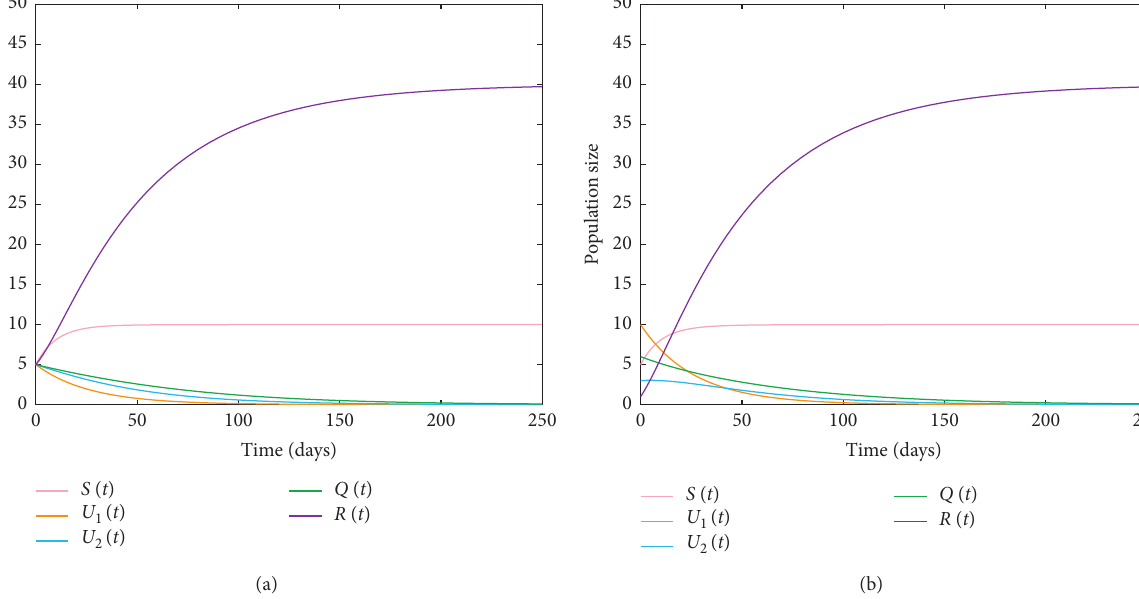
with different initial values when α 0